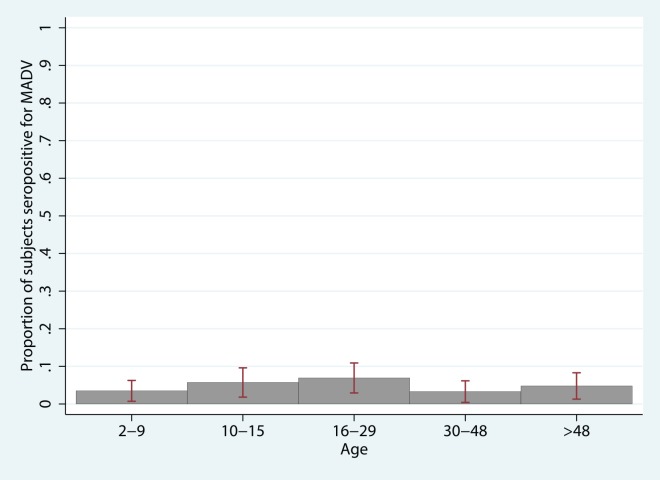
Age structure of VEEV seroprevalence.Table displays odds ratios, 95% confidence interval, and p-value for univariate logistic regression of VEEV seropositivity with each unit increase in age (unit = one year).